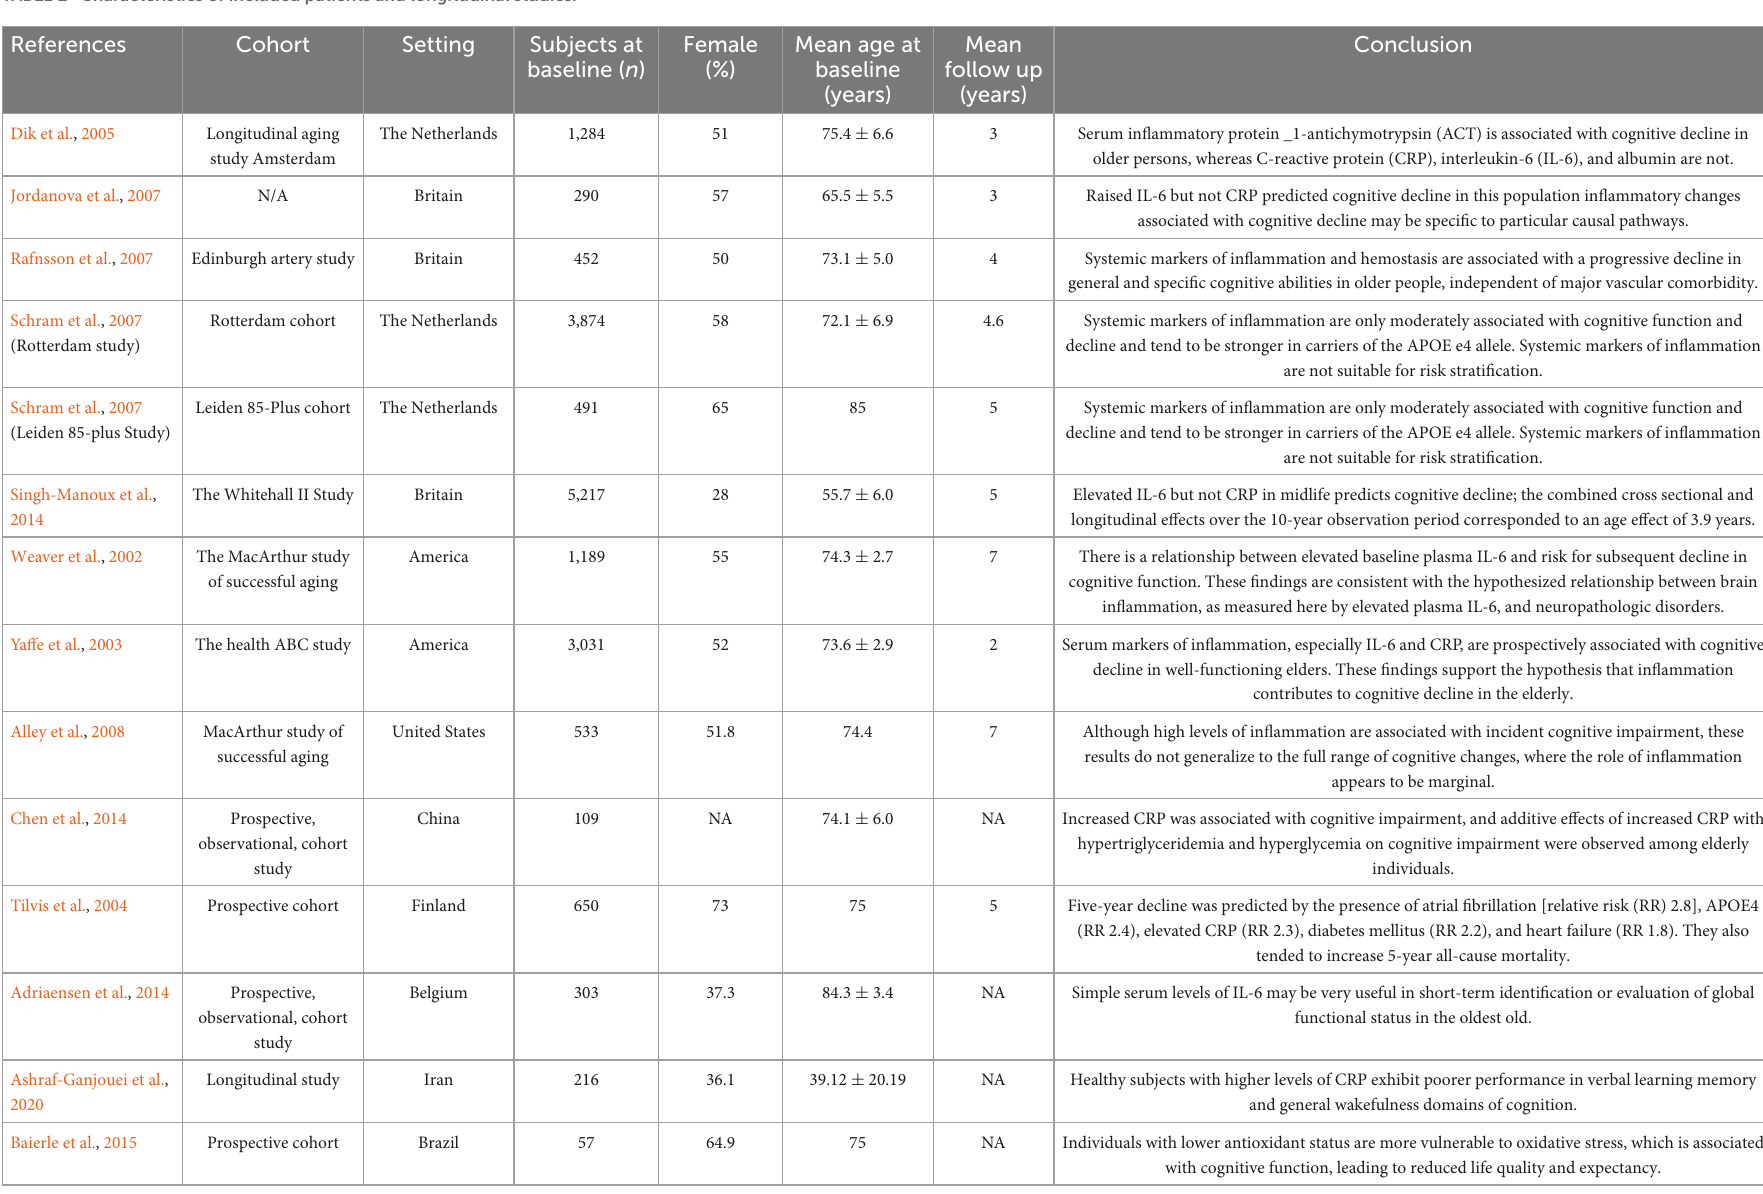
TABLE 2 Characteristics of included patients and longitudinal